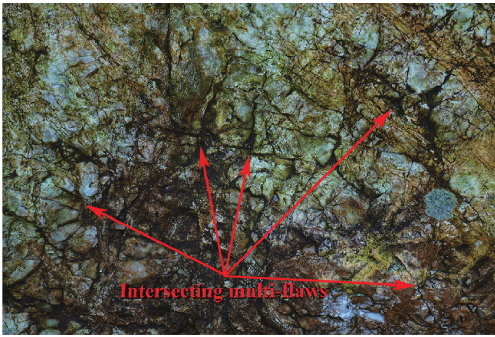
Figure 2: A rock mass containing